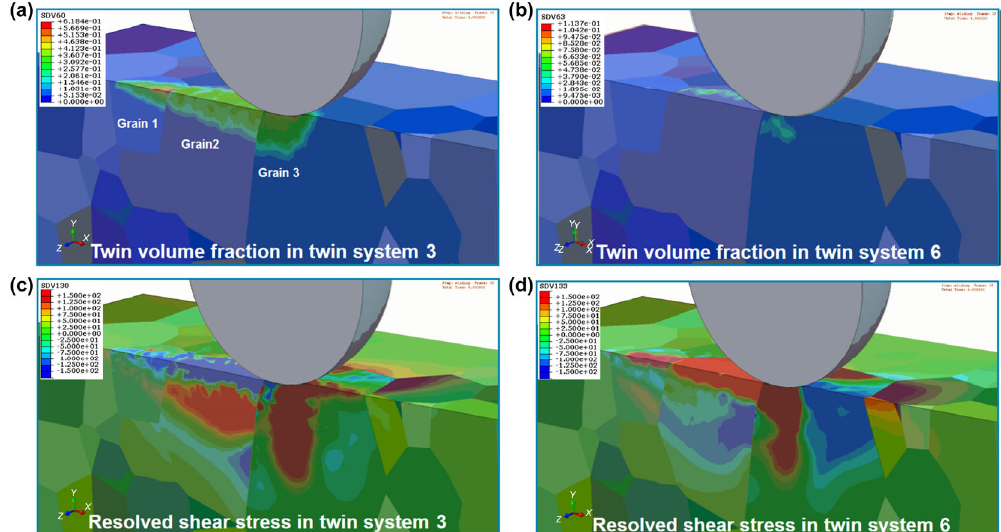
Fig. 4 Twin volume fraction and resolved shear stress in (a) twin system 3 and (b) twin system 6 for Case I. Red color in resolved shear stress denotes positive stress and blue color negative